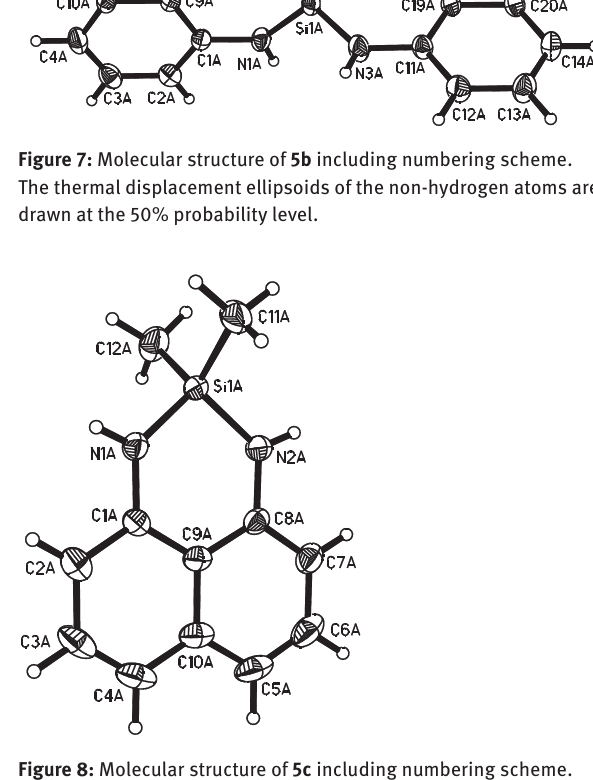
Figure 8: Molecular structure of 5c including numbering